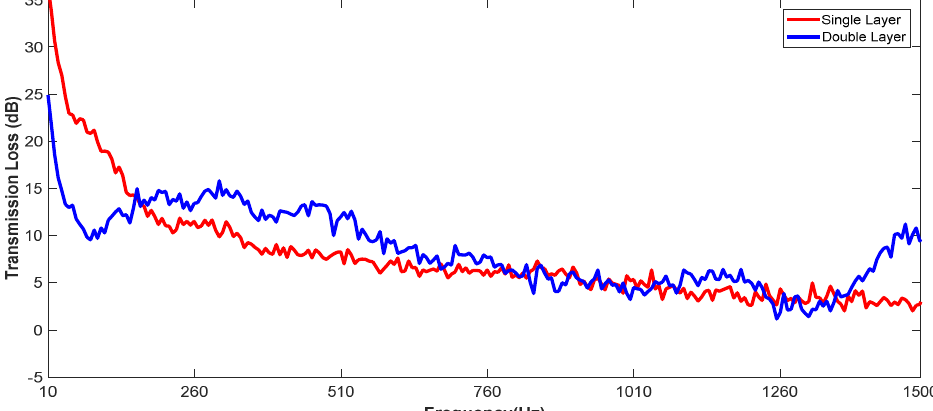
Fig. 8. The acoustic transmission loss versus frequency. The data were collected with air cross-velocity equal to (25m/s) using the perforated